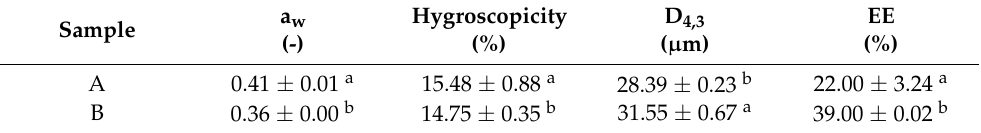
Table 1. Water activity (a w ), hygroscopicity, average particles size of powders, and encapsulation efficiency of flaxseed